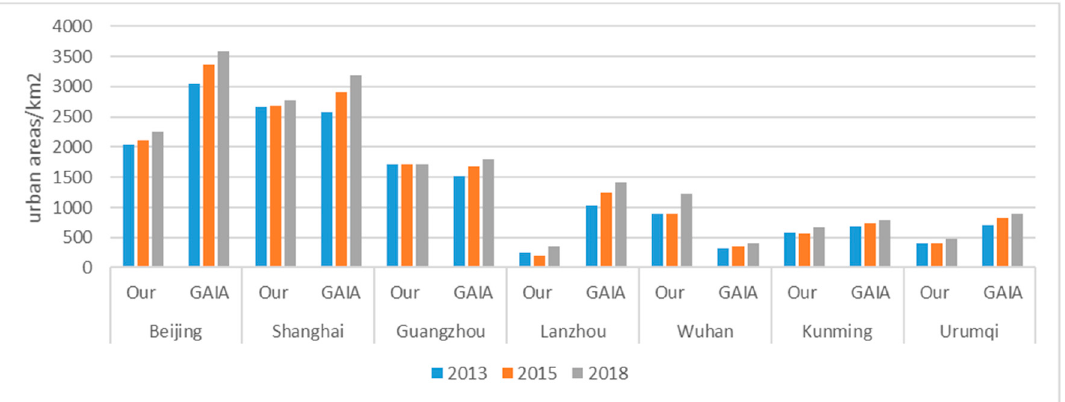
Figure 11. Growth of urban areas from 2013 to 2018.